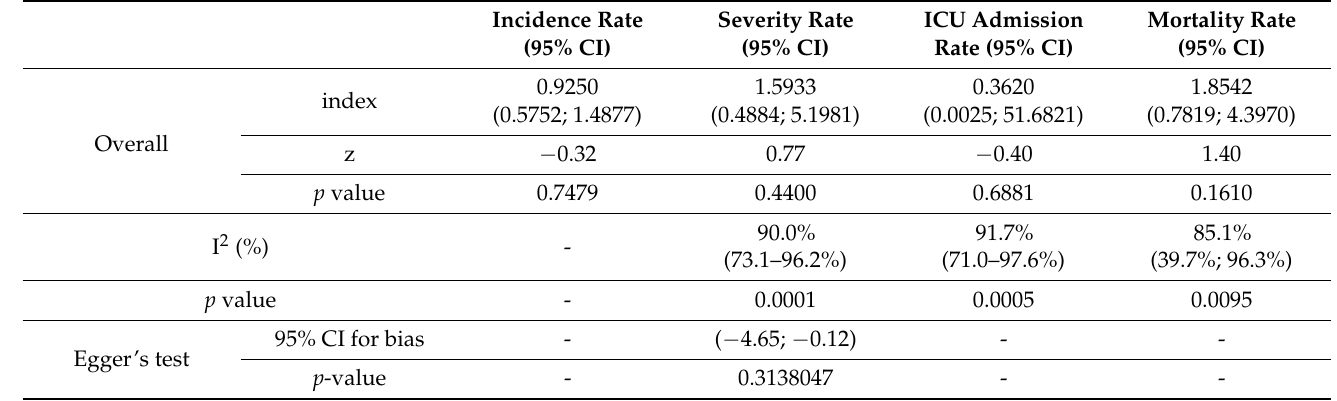
Table 2. Computed results concerning the different studied